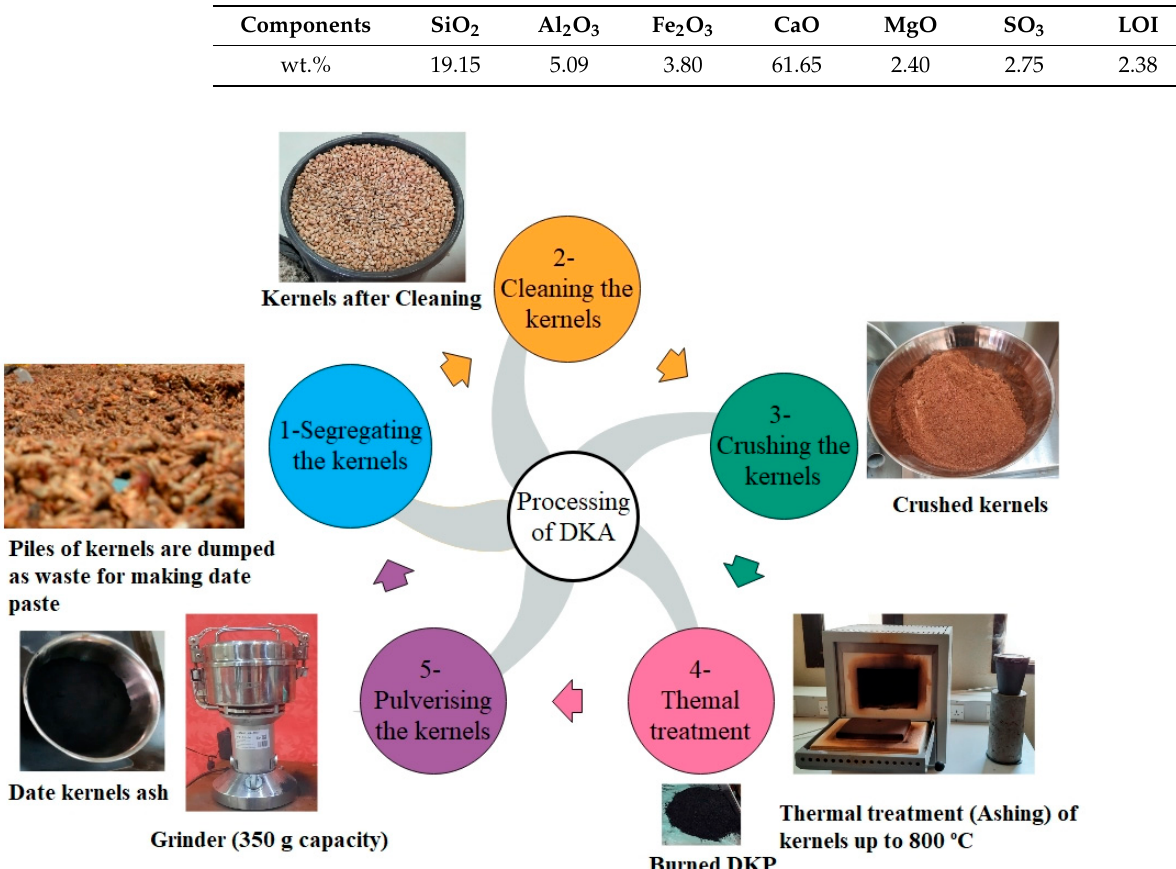
Table 1. Chemical analysis of OPC.